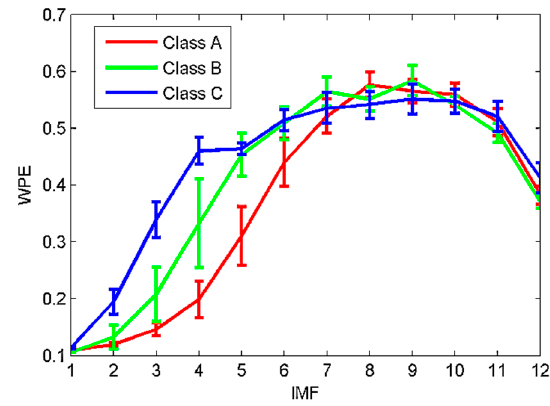
Figure 15. The mean and standard deviation of